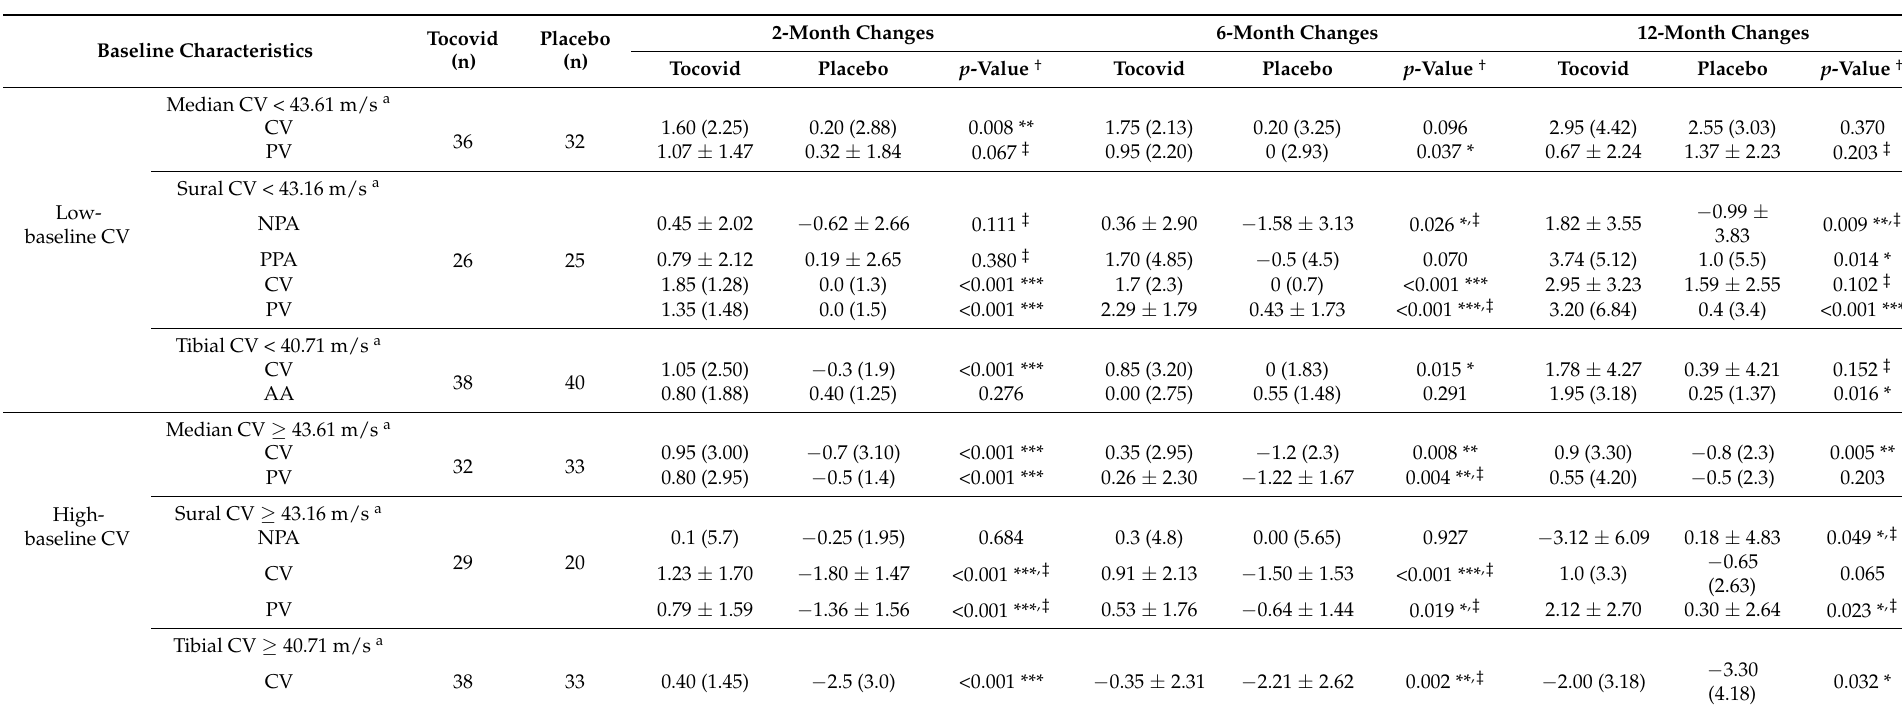
Table 8. Subgroup analysis comparing changes in nerve conduction parameters between intervention groups, stratified according to baseline conduction velocity